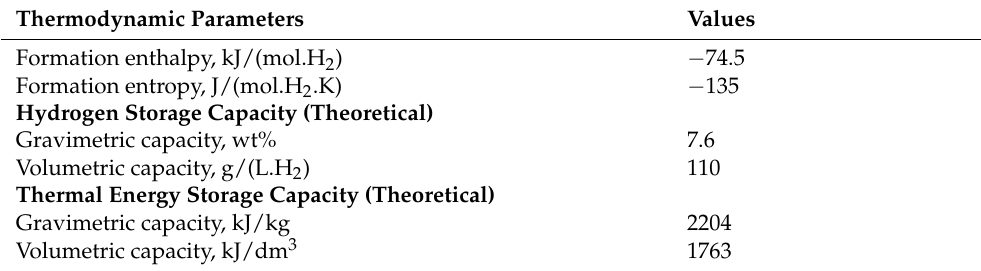
Table 2. Thermodynamic parameters and energy storage properties of MgH 2 [65]. Thermodynamic Parameters Values Formation enthalpy, kJ/(mol.H 2 ) − 74.5 Formation entropy, J/(mol.H 2